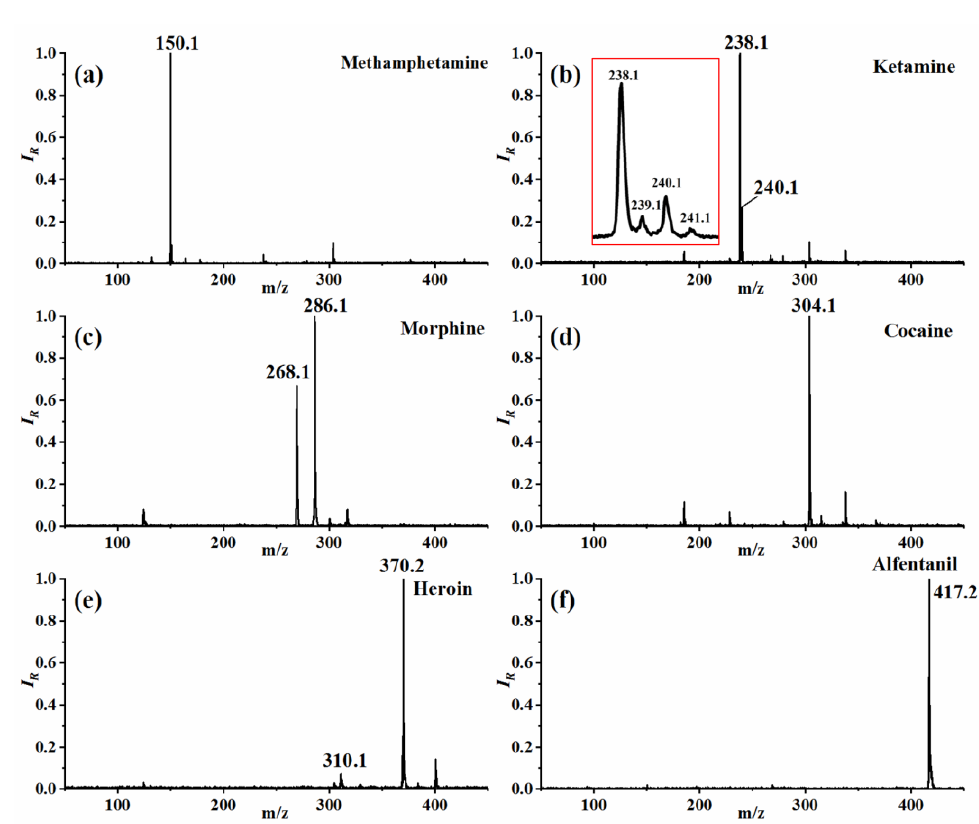
Figure 2. Mass spectra of six representative narcotic samples. (a) Methamphetamine; (b) Ketamine; (c) Morphine; (d) Cocaine; (e) Heroin; (f) Alfentanil. The characteristic isotopes of ketamine were shown in the red box embedded in (b).